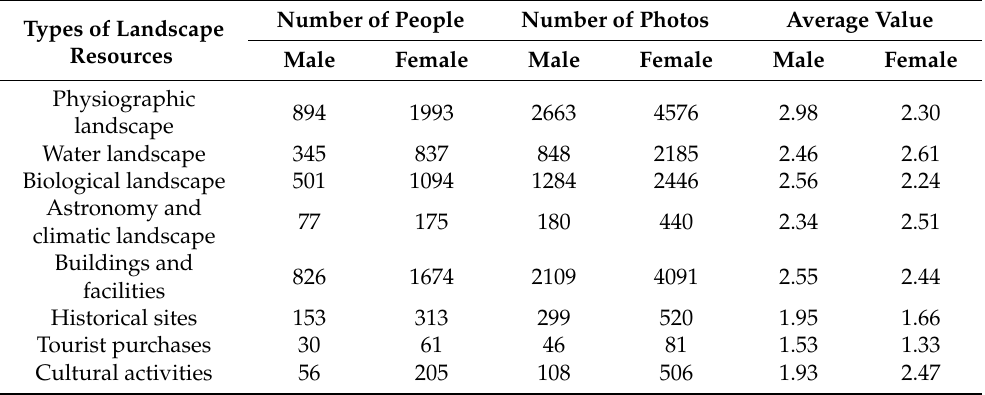
Figure 4. Analysis of tourists’ landscape preferences and its difference among different genders. Table 6. The frequency with which landscape types were visited by each gender.